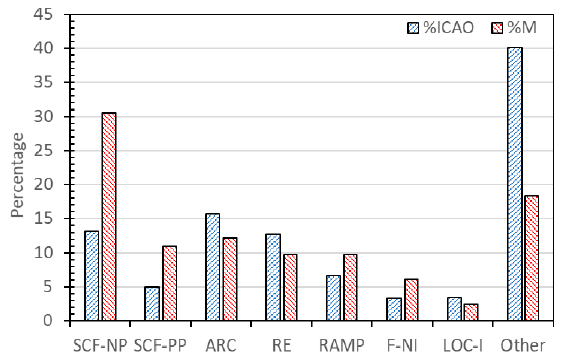
Figure 4. Distribution of occurrence categories for accidents with maintenance contributions.